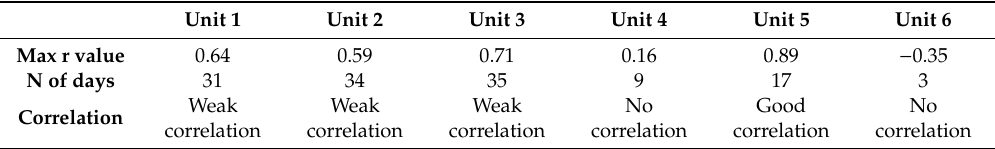
Table 6. Correlation analysis between daily displacement and antecedent precipitation for the sites of GNSS